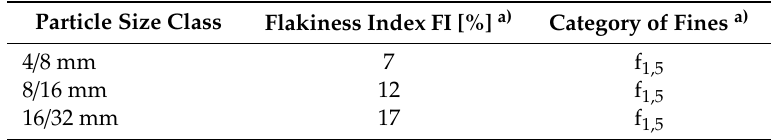
Table 5. Flakiness index and fines for processed excavation material at the access tunnel